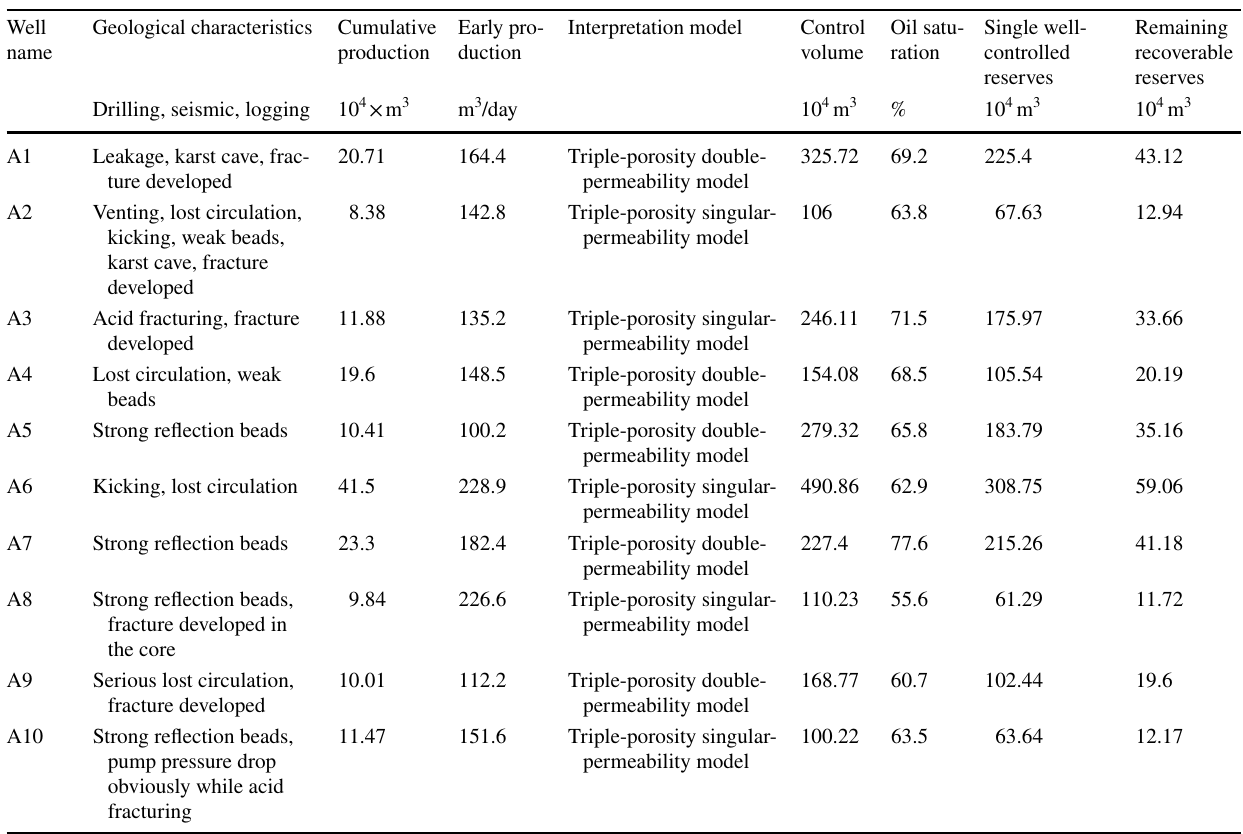
Table 2 The calculation results of type I well in X block